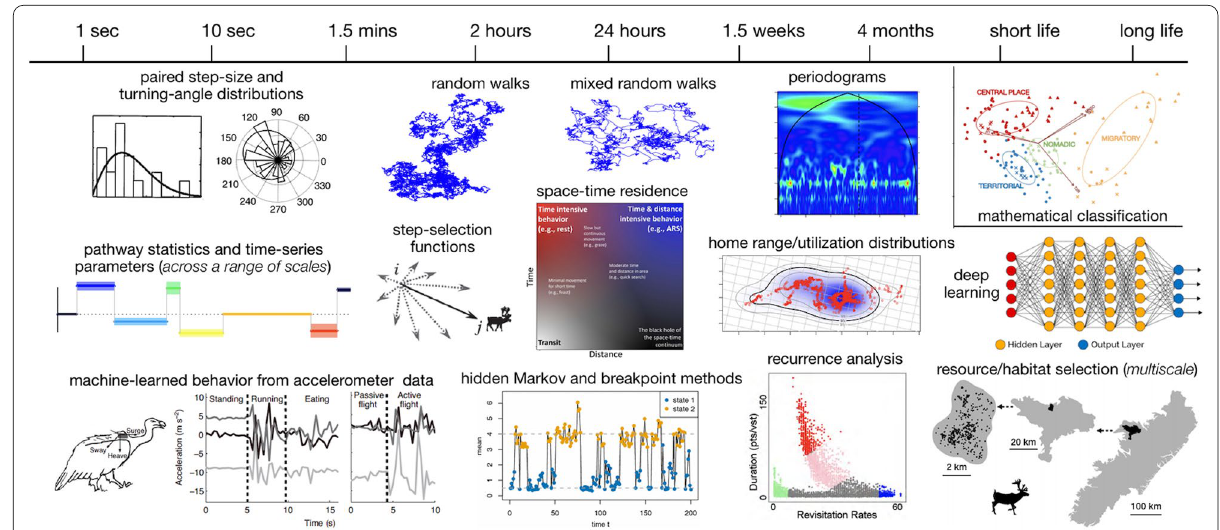
Fig. 4 Current scale-dependent analytical methods for analyzing movement paths. The temporal range is only suggestive and best applied to medium and large vertebrates. Also the image placements are not precise and some methods, such as machine learning (Thessen 2016), can be applied to data at any scale, but here are associated with the scale at which they are likely to be most useful. In addition, deep learning (useful for identifying different types of long-term patterns) is actually a subset of machine learning (where other machine techniques, such as random forests and support vector machines have been applied to accelerometer data; Nathan et al. 2012; Fehlmann et al. 2017). Stochastic walks include correlated and biased random walks (Johnson et al. 2008). Space–time residence analyses represent a family of methods that include first-passage-time (FPT; Fauchald and Tveraa 2003; McKenzie et al. 2009) and related approaches (Torres et al. 2017), while recurrence analyses cover a plethora of methods used to identify recursive movement patterns (Berger-Tal and Bar-David 2015; Bar-David et al. 2009). The melange of images is extracted from publications in the literature (Nathan et al. 2012; Panzacchi et al. 2016; Morales et al. 2004; DeCesare et al. 2012; Wittemyer et al. 2008; Lyons et al. 2013; Abrahms et al. 2017; Fleming and Calabrese 2017; Pohle et al. 2017; Torres et al. 2017; Gurarie et al. 2017), as well as